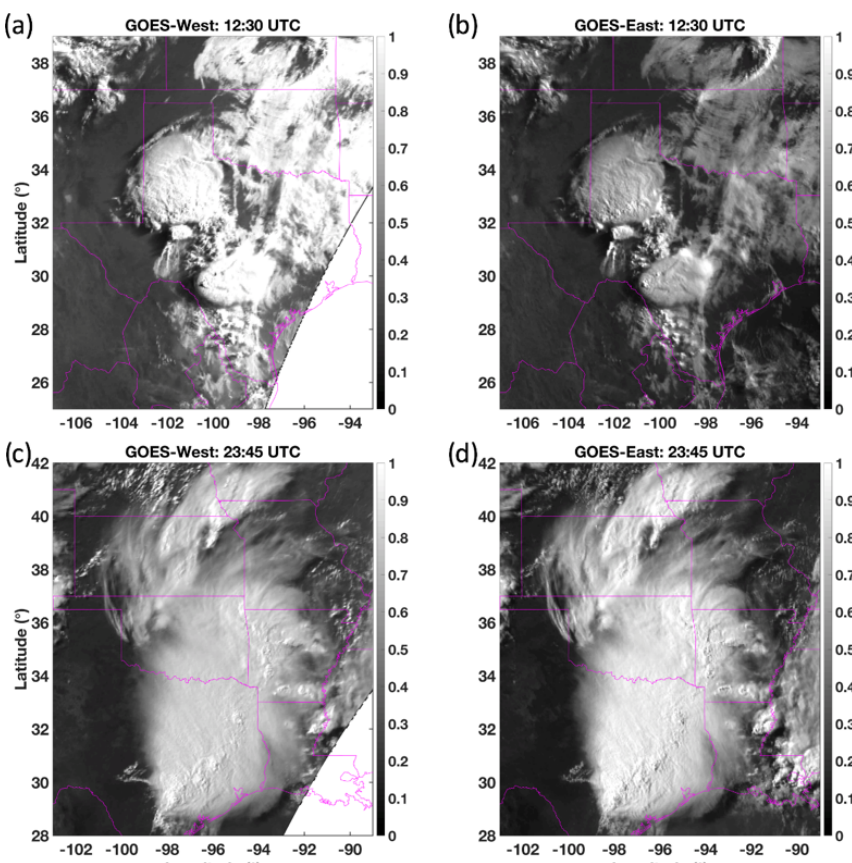
Figure 1. Intercalibrated MODIS-referenced VIS reflectance of a 25 May 2015 MCS over Texas and Oklahoma as viewed by (a) GOES- West (GOES-15) at 12:30UTC, (b) GOES-East (GOES-13) at 12:30UTC, (c) GOES-West at 23:45UTC, and (d) GOES-East at 23:45UTC, remapped to a common projection. The apparent brightness of the MCS changes as the solar illumination and viewing conditions